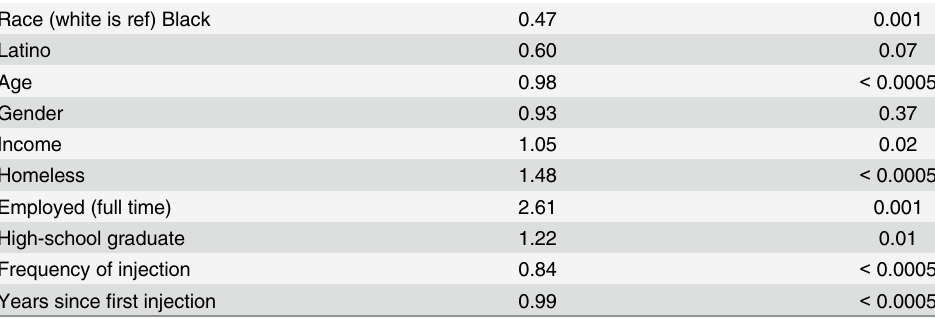
black isolation index was 27.6 points lower, and the Latino isolation index was 18.8 points Table 6. Bivariate associations between HIV negative status and participant characteristics 1